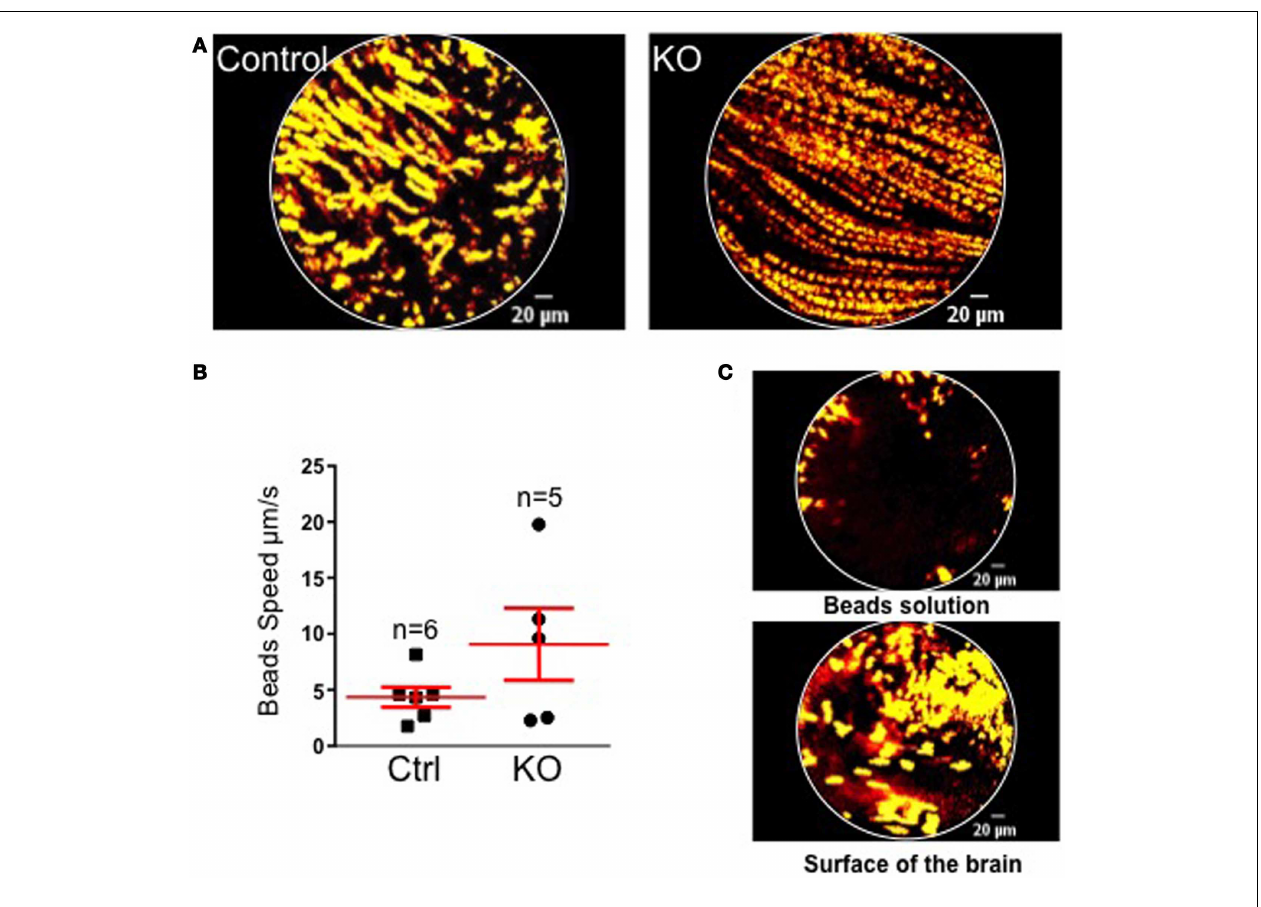
speed of the beads in control and KO MCHR1 animals. (C) Negative controls.Visualizations of fluorescents beads in solution (top) and at the surface of the living brain (bottom). No orientated movements were